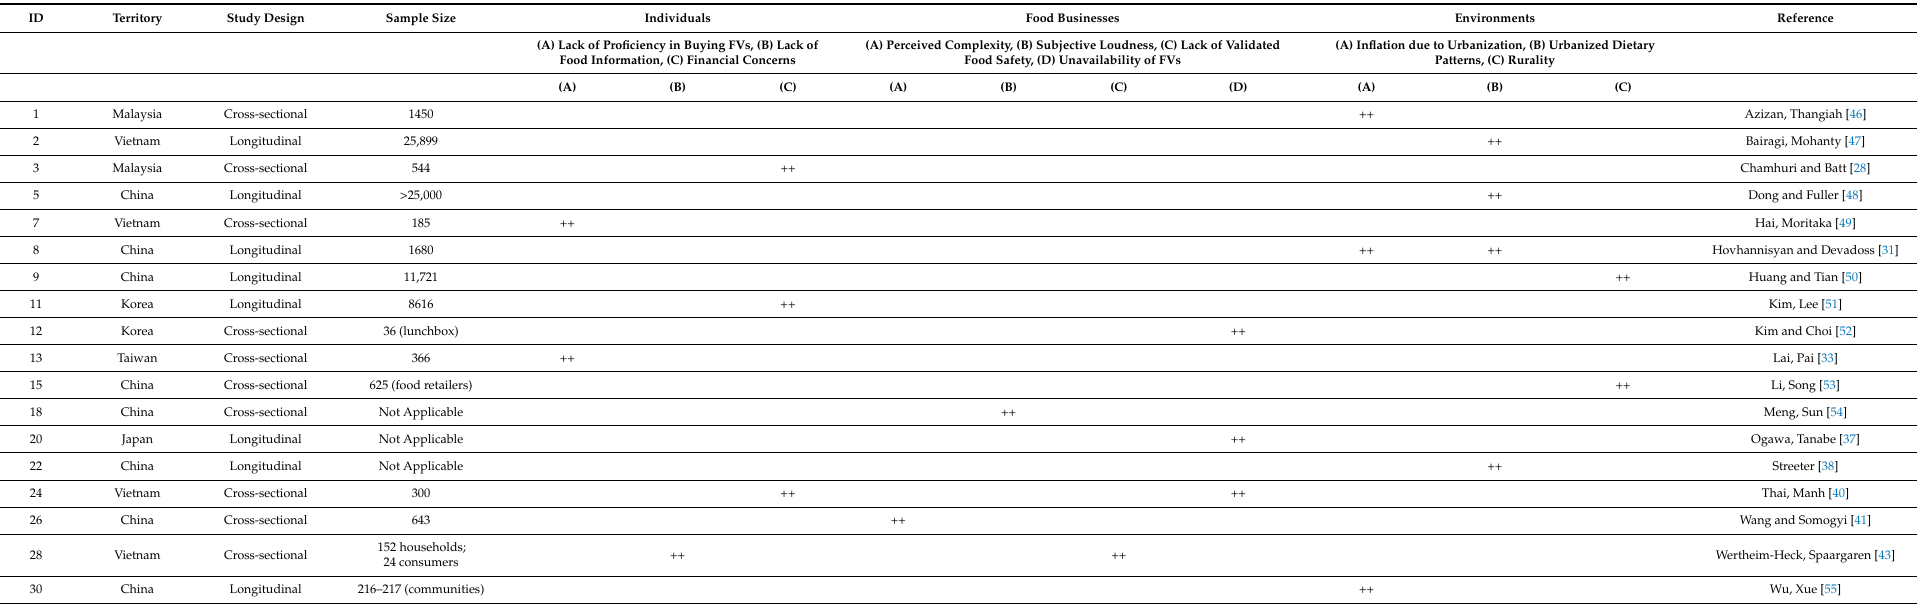
Table 4. Barriers to FV consumption in East and Southeast